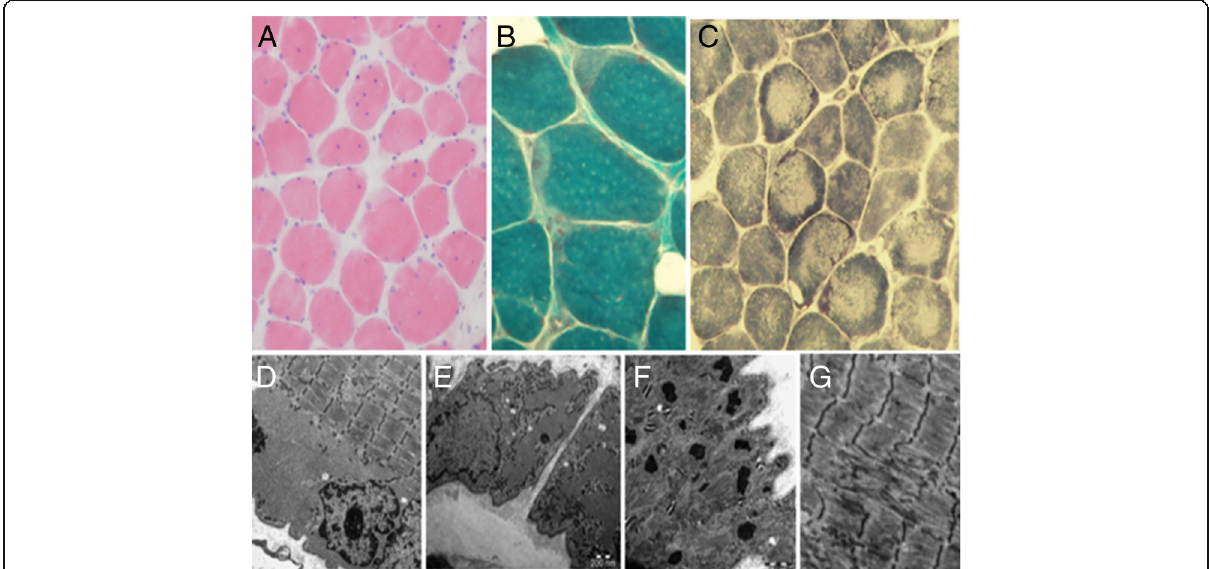
Fig. 3 Muscle biopsy results. Myopathic changes: increased fiber-size variation, internal nuclei, endomysial fibrosis ( a ). Subsarcolemmal storage material staining bright on HE ( a ) and with modified Gomori ( b ), dark on NADH ( c ). The storage material beneath the sarcolemma is clearly visible on the electron microscopic (EM) image ( d ). An atrophic fiber is almost completely filled with granular storage material ( e ). Structural alterations of fibers: dysorganized sarcomers and abnormal electrondense bodies ( f ), „ core-like ” appearance of fibers with NADH ( c ) and core structures on EM ( g ). Original magnifications: A: 80×, B: 160×, C: 80×, D: 10.000×, E: 7.500×, F: 20.000×, G: